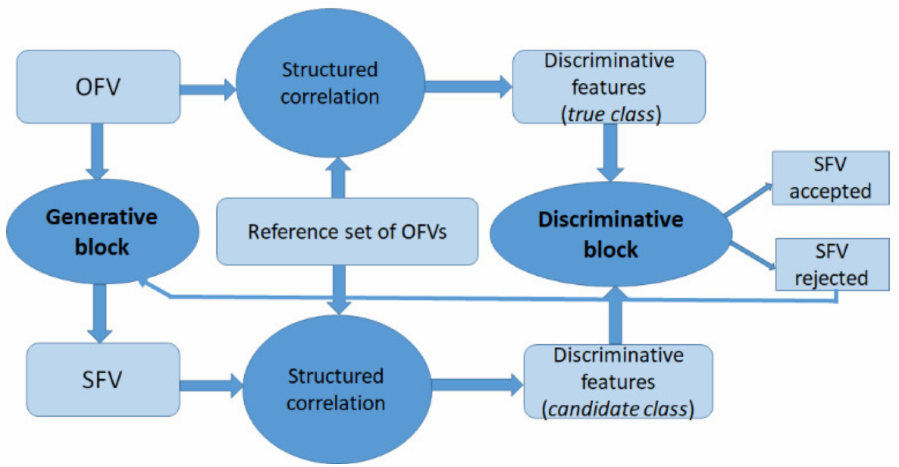
Figure 2. Description of the oversampling method GANSO. OFV, Original Feature Vector; SFV, Synthetic Feature